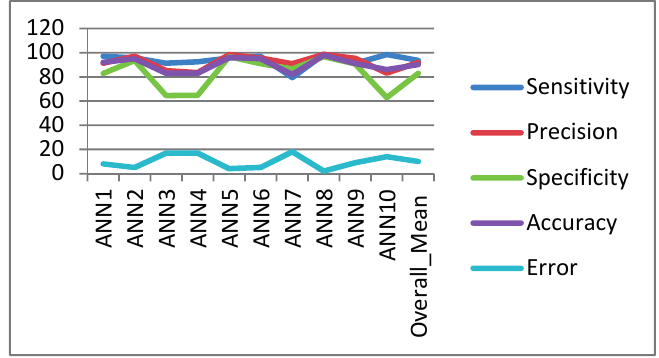
Figure 12. Performance criteria of ANN with 10-fold cross